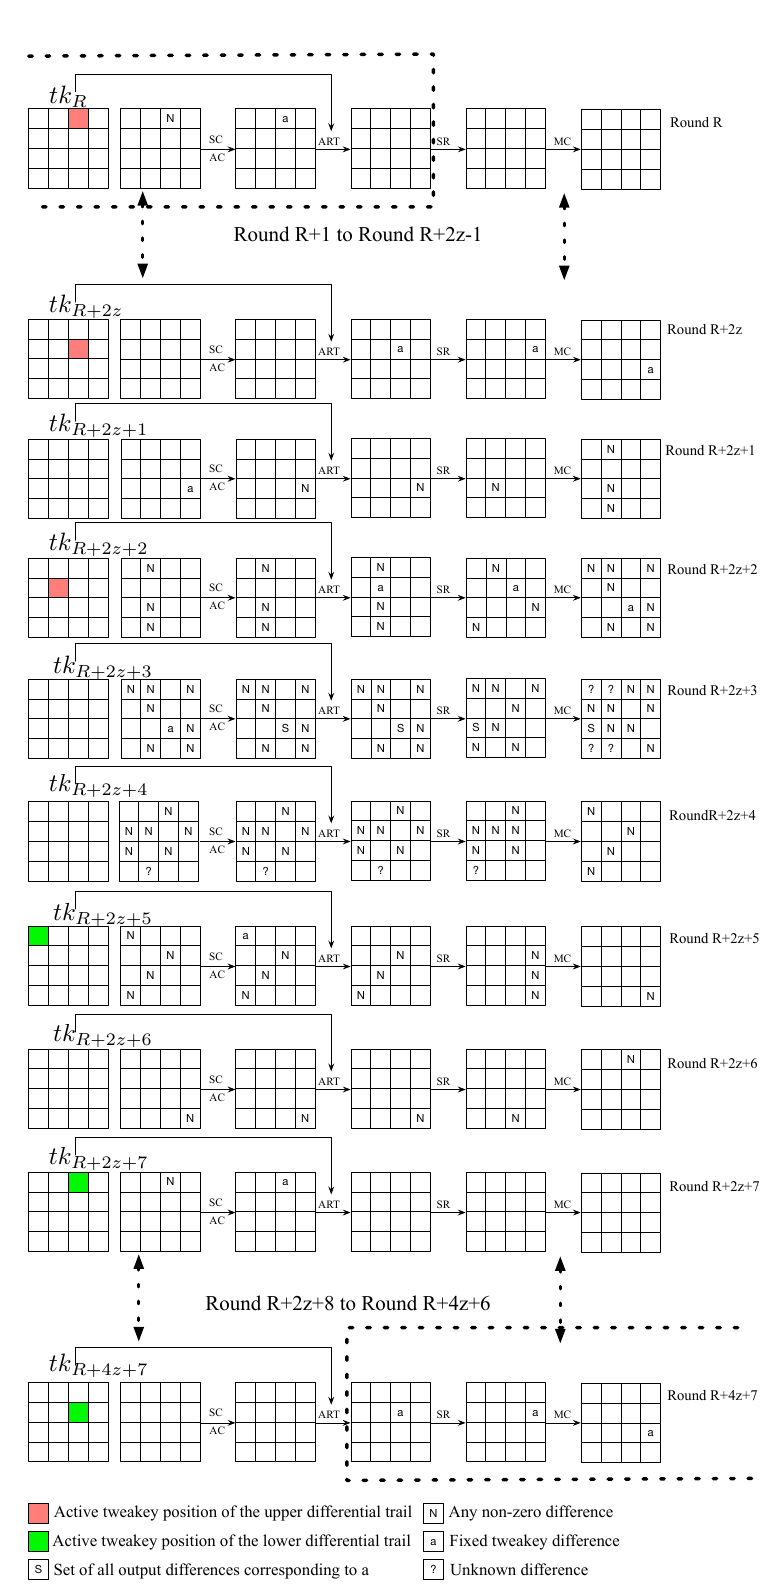
Figure 7: Description of the generalized related-tweakey rectangle